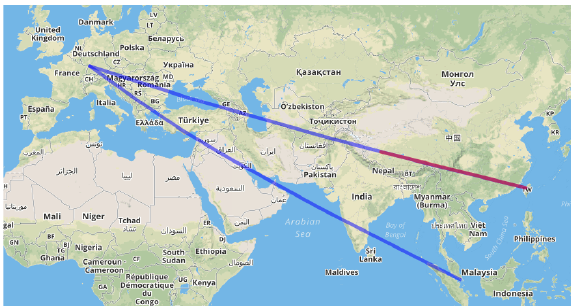
Figure 2. FCU/CODE-DE federation query path: query sent to CODE-DE from Singapore, subquery generated for FCU